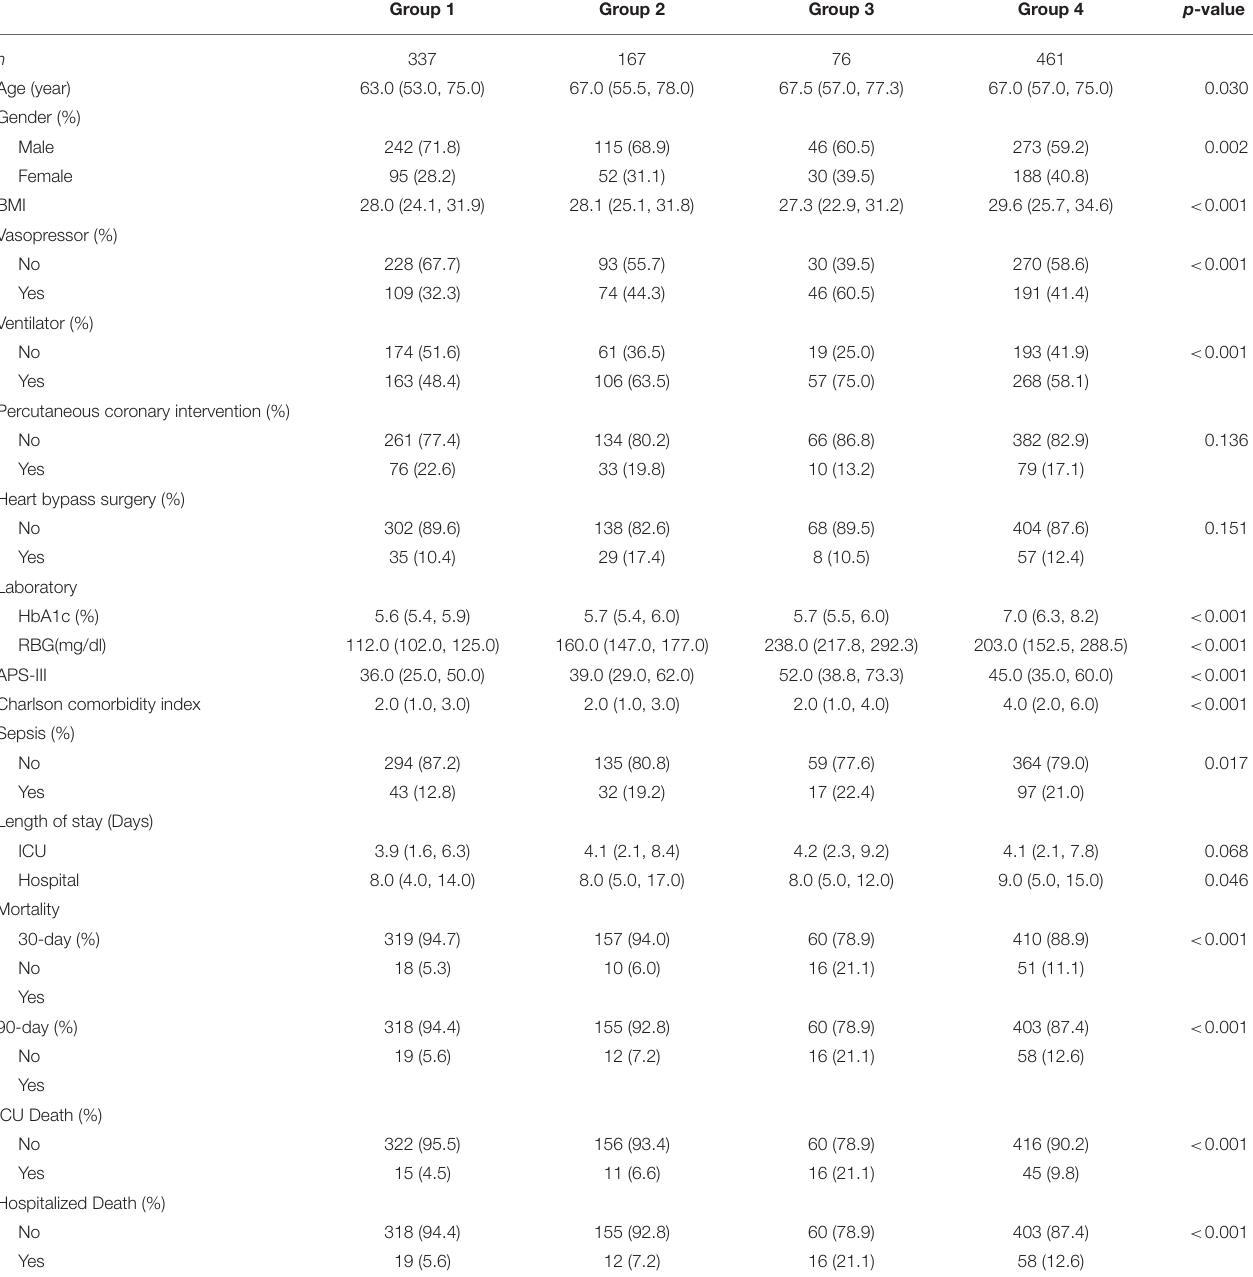
TABLE 1 | Baseline characteristics of the study